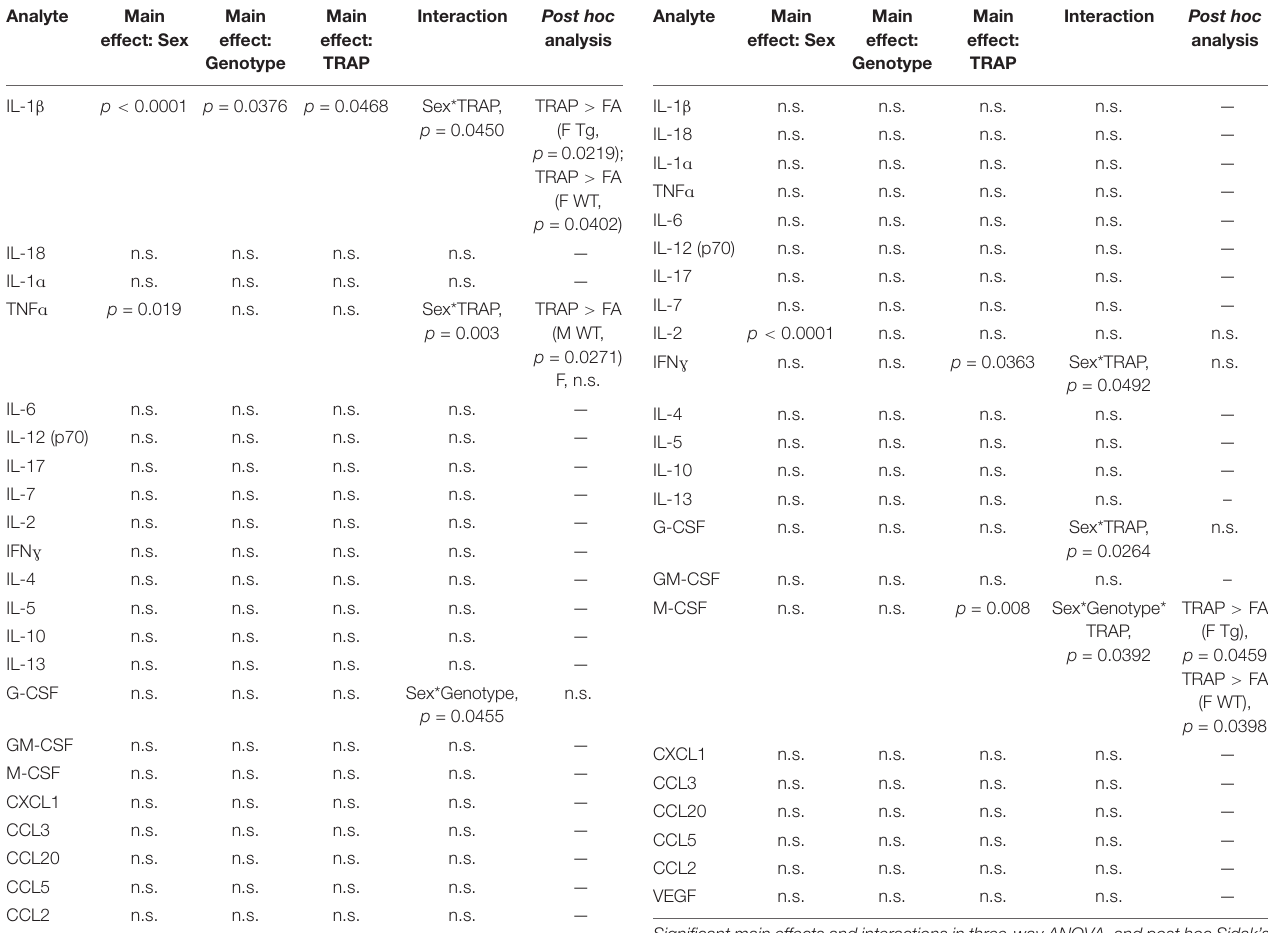
TABLE 2 | Summary of statistical comparisons for levels of cytokines, chemokines, and growth factors in the hippocampus of 6-month-old TgF344-AD and WT rats exposed to TRAP or FA for 5